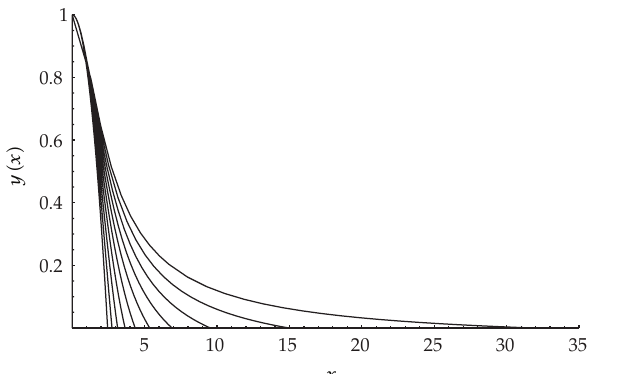
Figure 1: Lane-Emden graphs obtained by the present method for α (cid:5) 0, 0.5, 1,...,